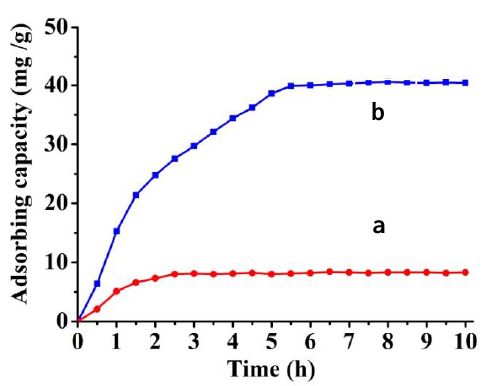
Figure 6. Adsorption dynamic of ( a ) NIP; and ( b ) MIP in bovine serum diluted with 20 times volume of water.